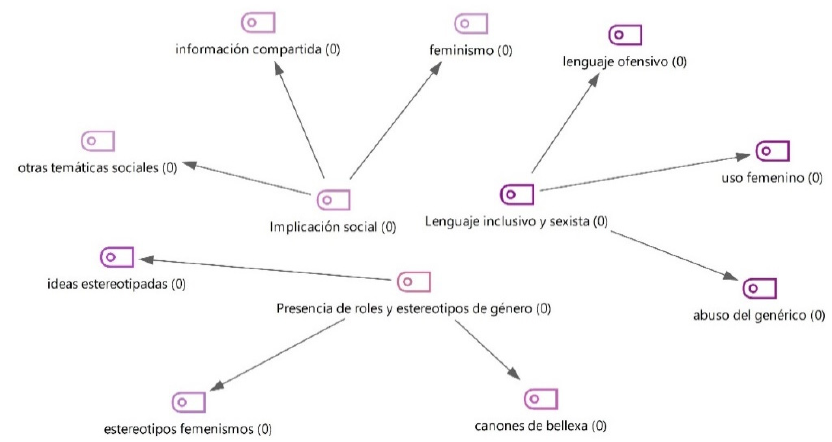
Figure 1. Descriptive codification of analysis units: categories and codes. 3